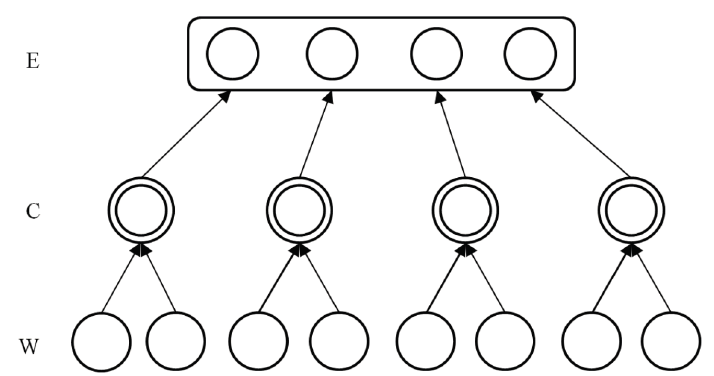
Figure 5. The dimensionality reducing process of Event